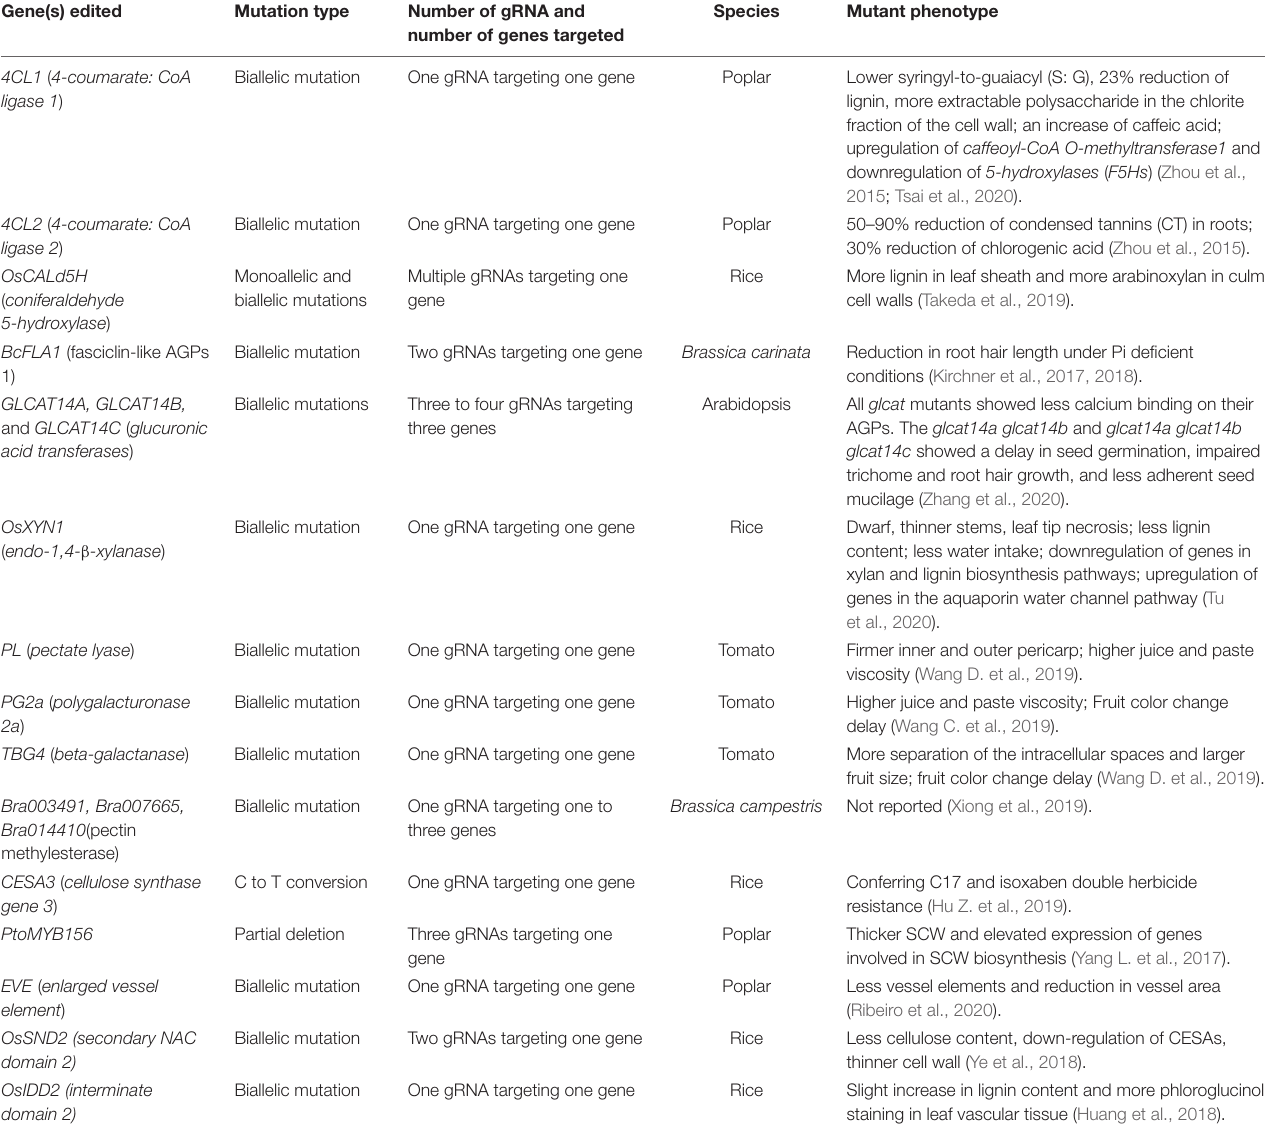
TABLE 1 | Examples of plant cell wall related genes edited by